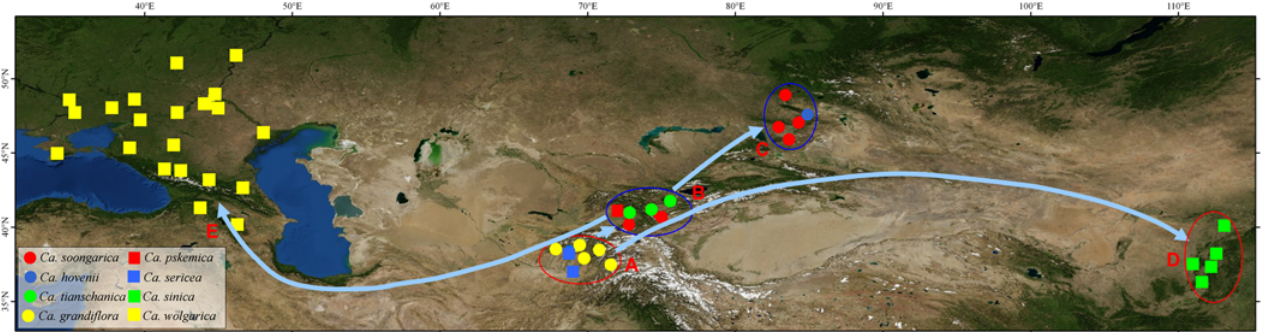
Fig 1. Distribution of Calophaca species as estimated from our field investigations in China, and floras and herbaria (PE, XIJI, LE, MW, MAH). The place of origin of the genus, the Pamir — western Tianshan, and dispersal routes in three different directions are